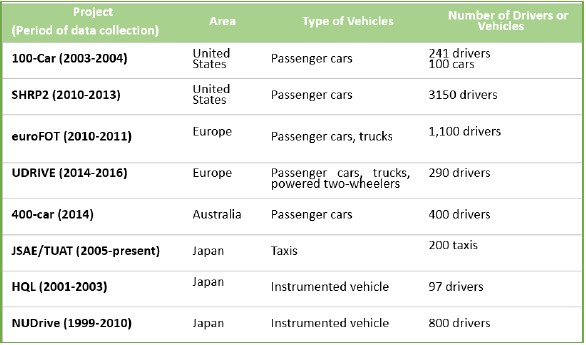
Figure 8. Examples of on-road driving-data corpora